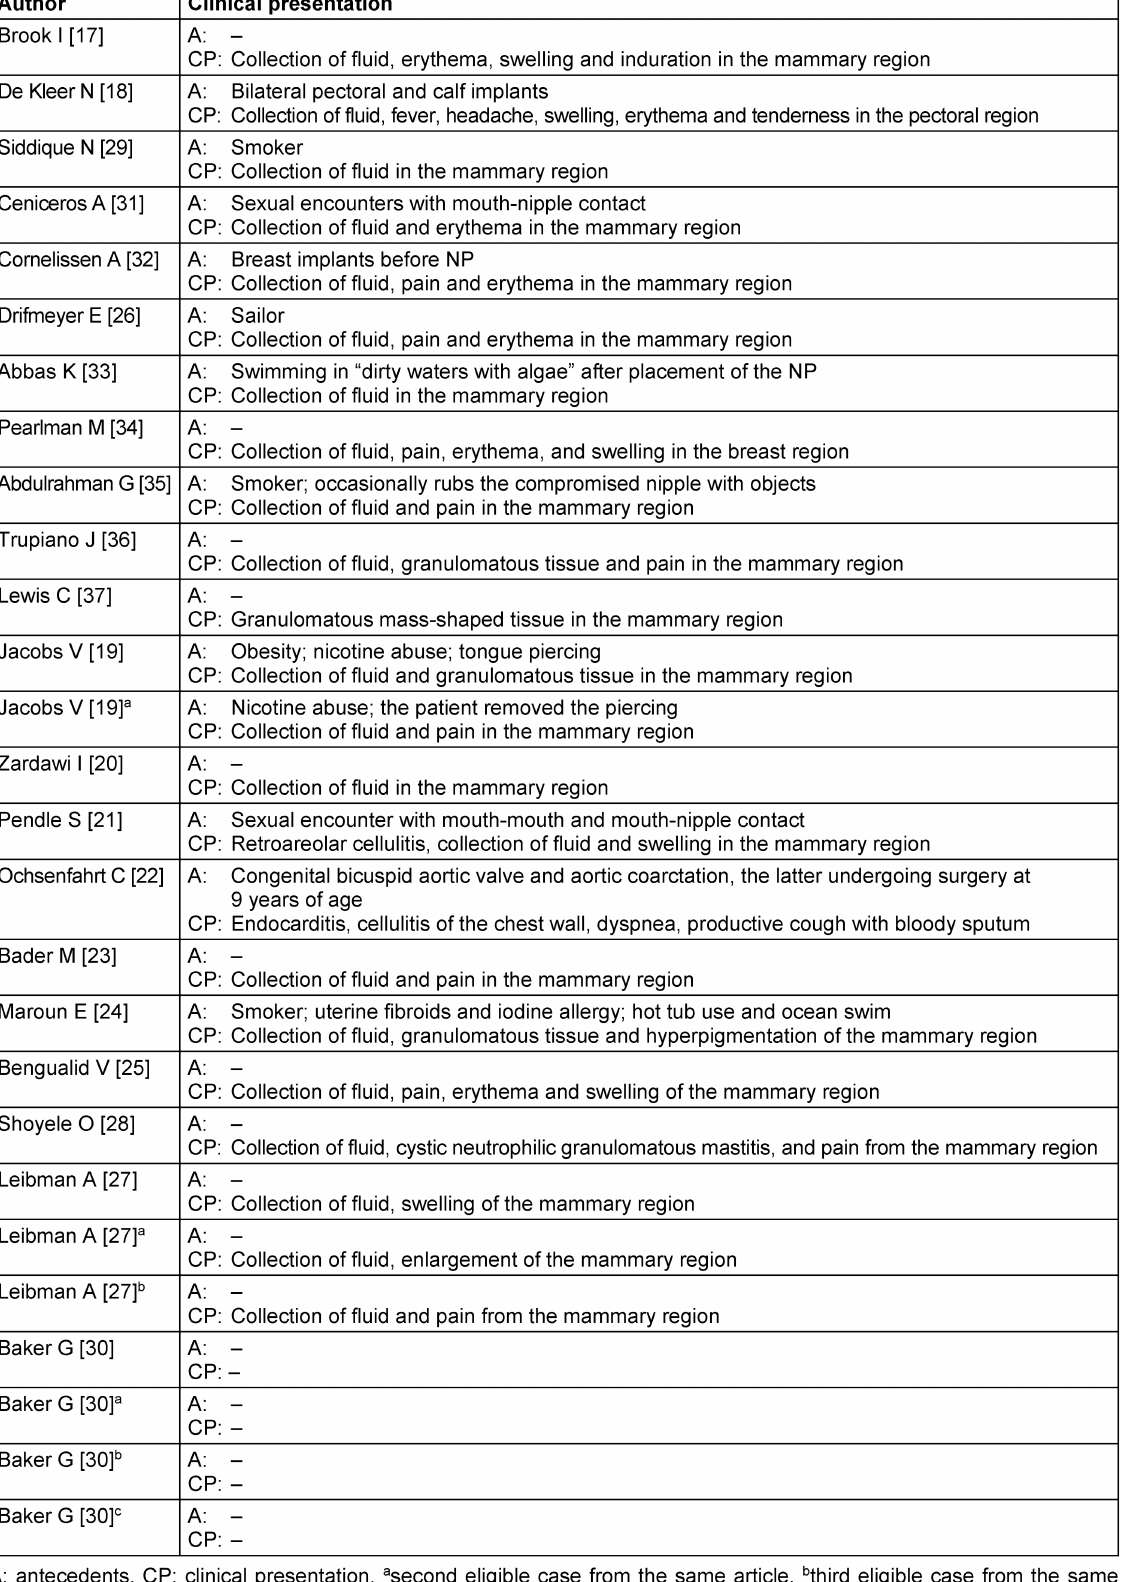
Table 2: Antecedents and clinical